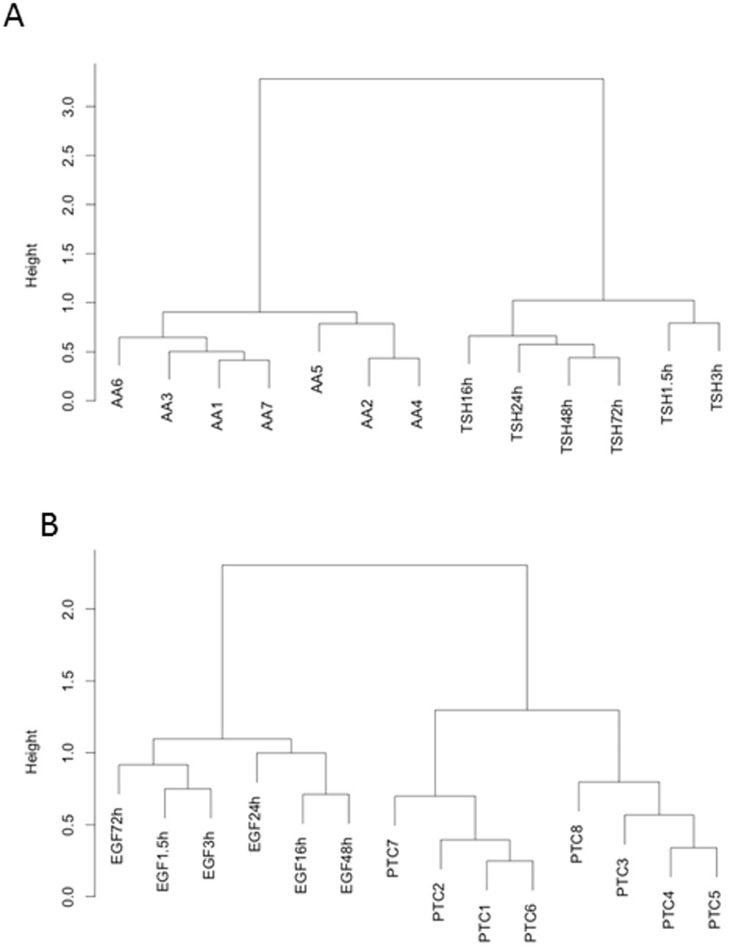
Hierarchical clustering on the miRNA expression data from primary cultures treated with TSH or with EGF/serum and from tumor tissues.Hierarchical clusterings were generated using R 2.8.1. The method used to compute the distance was “Ward”. A. Hierarchical clustering on the data from the primary cultured thyrocytes stimulated with 0.3 mU/ml of TSH for 1.5, 3, 16, 24, 48 and 72 hours and from 7 autonomous hyperfunctioning adenomas (AA). A time evolution in miRNA expression according to TSH treatment of primary cultured thyrocytes is observed suggesting fine changes in miRNA level. The AA cluster apart from the TSH treated primary cultures indicating a clear separation between those two groups of samples. Each time point is the mean of triplicates. B. Hierarchical clustering on the data from primary cultured thyrocytes stimulated with 25 ng/ml EGF and 10% serum for 1.5, 3, 16, 24, 48 and 72 hours and from 8 papillary thyroid carcinomas. In this case, no temporal evolution could be observed by hierarchical clustering. Each time point is the mean of triplicates. Tumors and treated primary cultures clustered apart, suggesting that primary cultures evolved differently according to the treatment but that there was no convergence to AA or PTC for the long-term treatment.